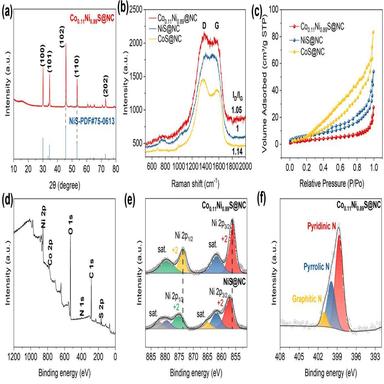
(a) XRD patterns of Co0.11Ni0.89S@NC; (b) Raman spectra of Co0.11Ni0.89S@NC, NiS@NC, and CoS@NC; (c) The adsorption–desorption isotherms of Co0.11Ni0.89S@NC, NiS@NC, and CoS@NC; (d) Full XPS spectra of Co0.11Ni0.89S@NC; High-resolution XPS spectra of (e) Ni 2p and (f) N 1 s.